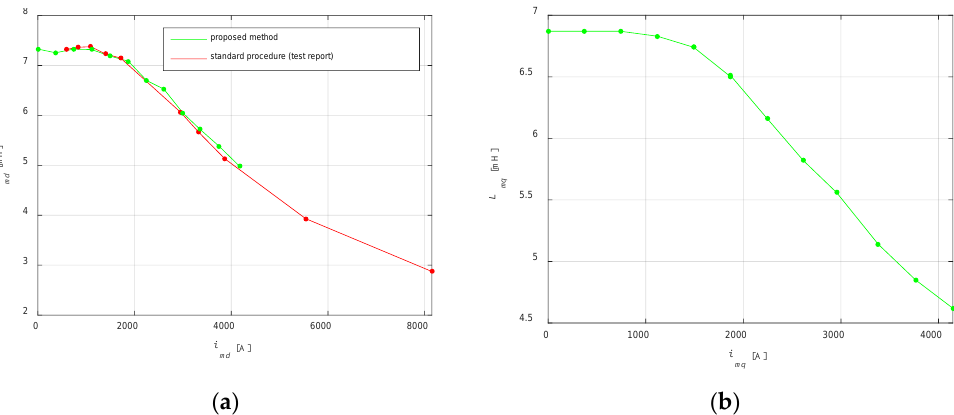
Figure 9. ( a ) comparison of obtained d -axis magnetization curve with that from a test report; ( b ) obtained q -axis magnetization curve.